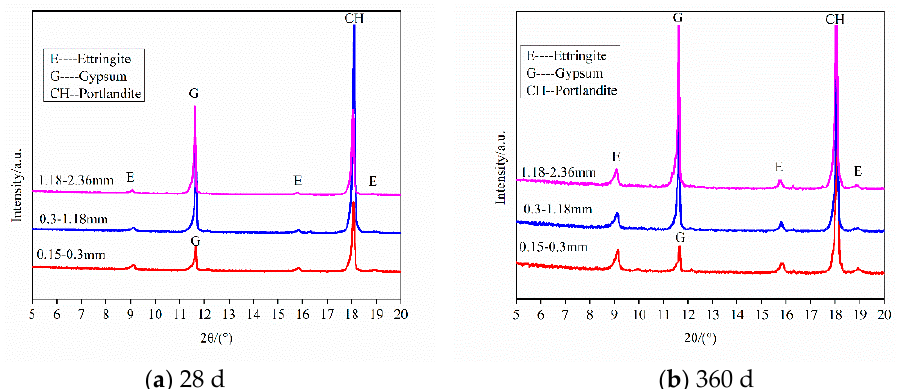
Figure 7. XRD patterns of mortars with different sizes of gypsum aggregate.